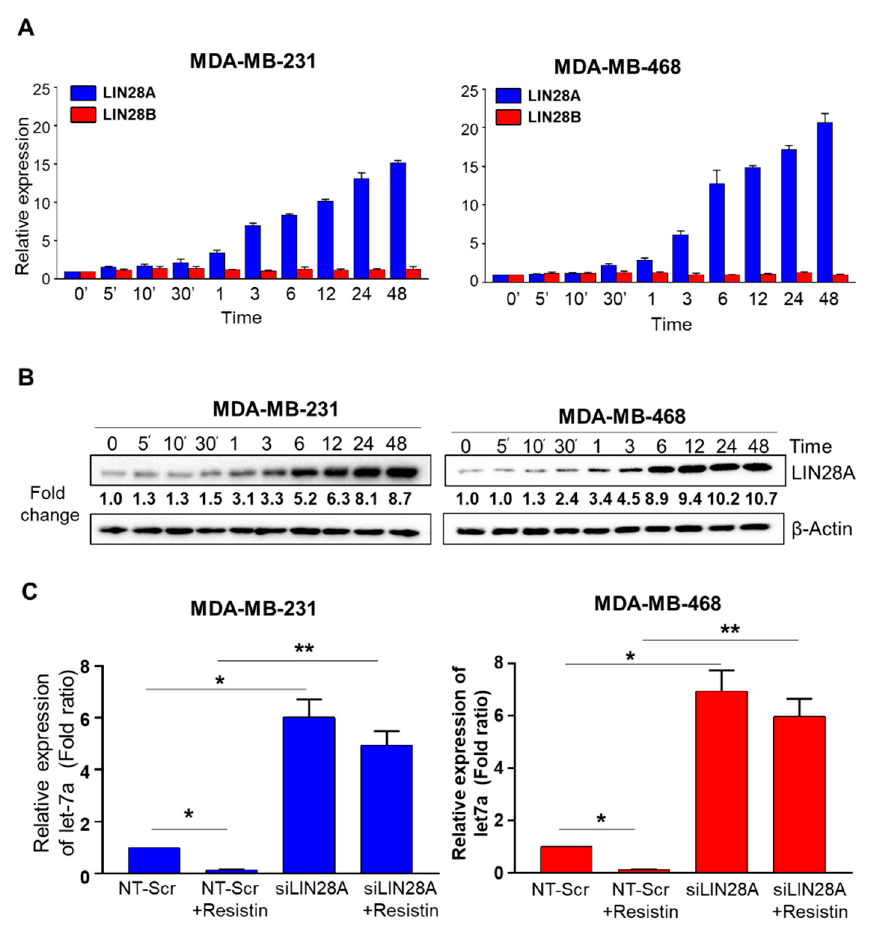
Figure 2. Resistin-induced Let-7a downregulation is mediated through LIN28A in breast cancer cells. BC cells were grown in a 6-well plate and treated with 20 ng/mL resistin for indicated time intervals, and the expression of LIN28A was examined at mRNA level by quantitative RT-PCR ( A ) and at the protein level by immunoblot assay ( B ). GAPDH (for mRNA) and β -actin (for protein) were used as internal controls. ( C ) BC cells were grown in six-well plates and transfected with NT-Scr or LIN28A-targeting siRNAs. After 24 h of transfection, cells were treated with resistin (20 ng/mL) for 24 h, RNA was isolated, and expression of Let-7a was monitored by RT-PCR. U6 was used as an internal control. Data are presented as mean ± S.D. n = 3. * p < 0.05, ** p <